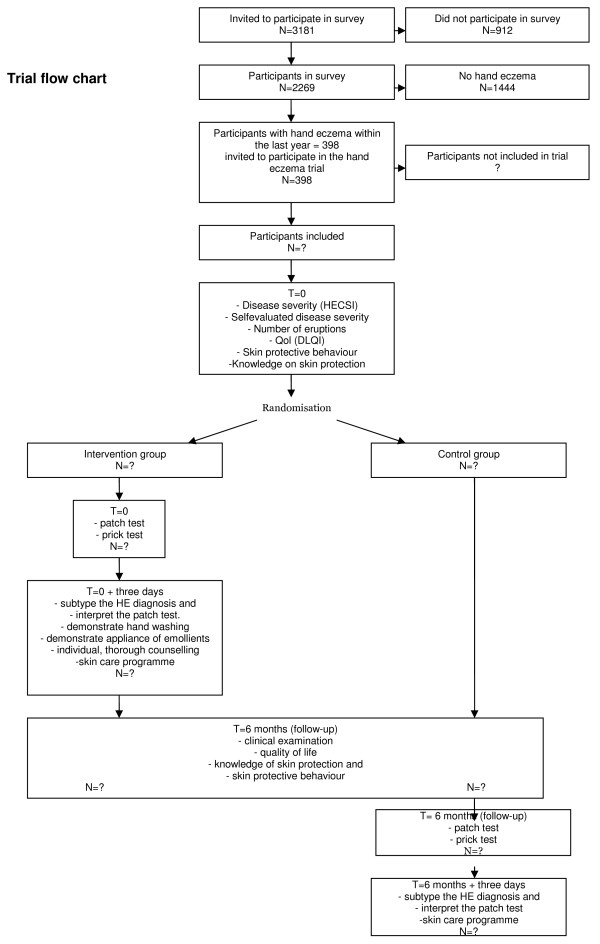
Trial flow chart.